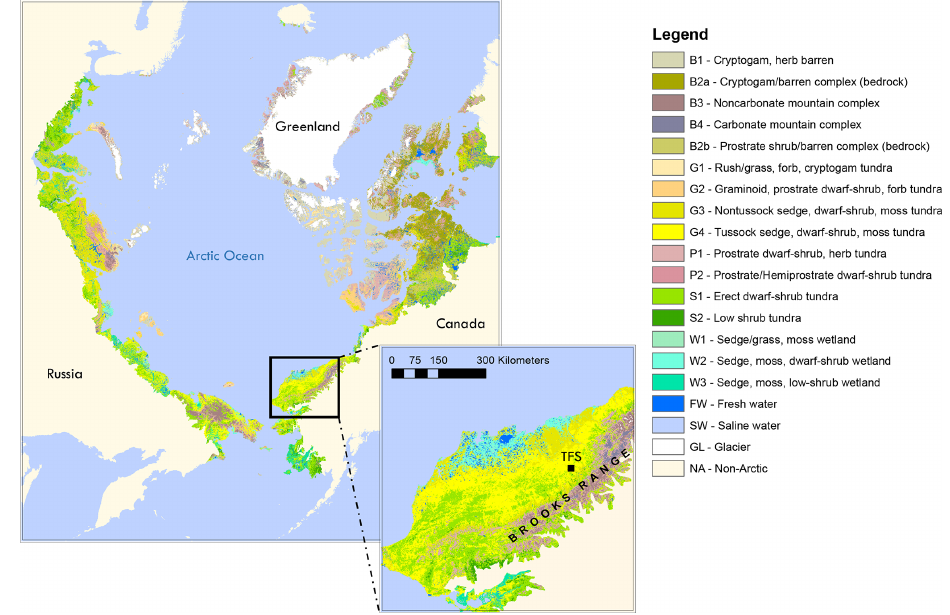
Figure 1. Location of Toolik Field Station (TFS) on the north flanks of the Brooks Range in northern Alaska along with arctic vegetation type. This figure was made using the raster version of the circumpolar Arctic vegetation map prepared by Raynolds et al. (2019), which is publicly available at https://www.geobotany.uaf.edu (last access: 19 May